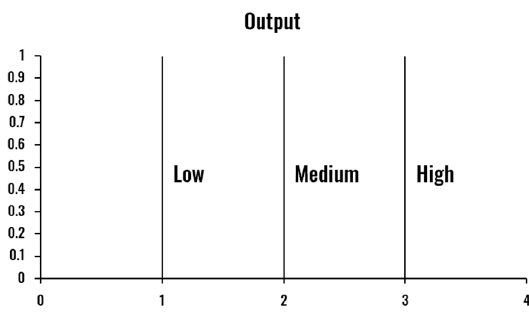
Figure 6. Fuzzy membership functions for drowsiness level output.